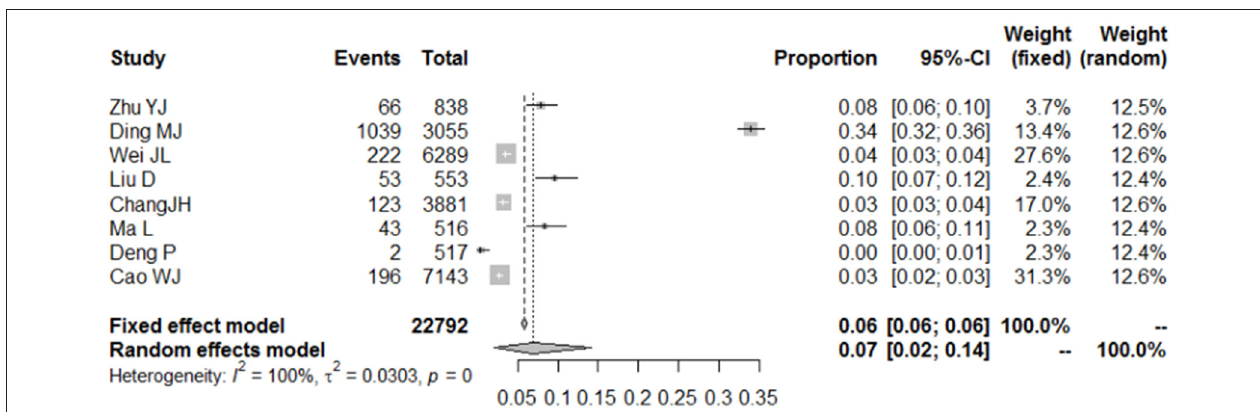
FIGURE 3 | Forest plot of the incidence of mild depression between genders.